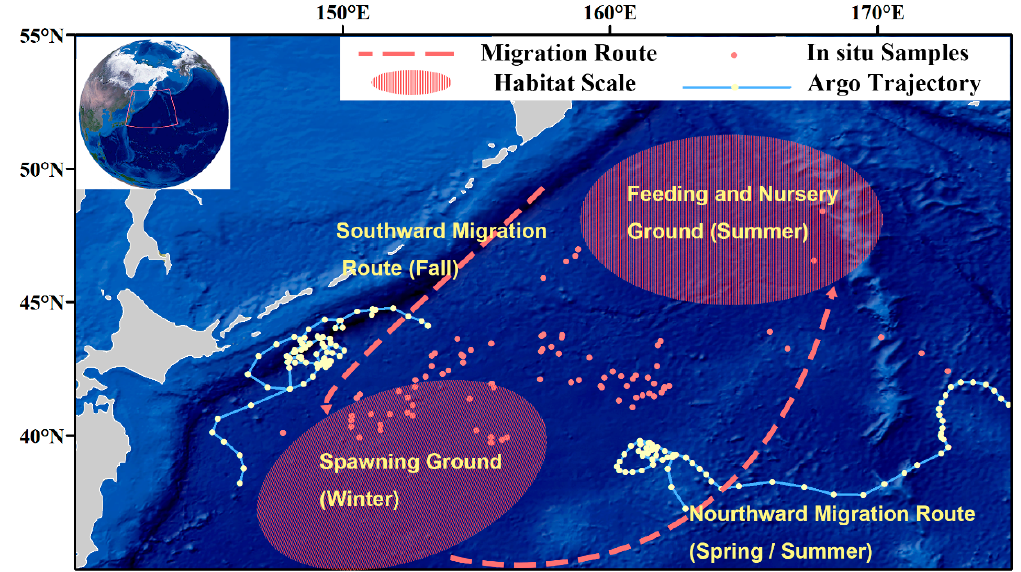
Figure 1. Research area including the locations of observation data and Argo trajectory in NPFG. The dotted lines are the annual migration routes of Pacific saury. Feeding and nursery ground, spawning ground, and northward (southward) migration route of Pacific saury are marked in the Figure.